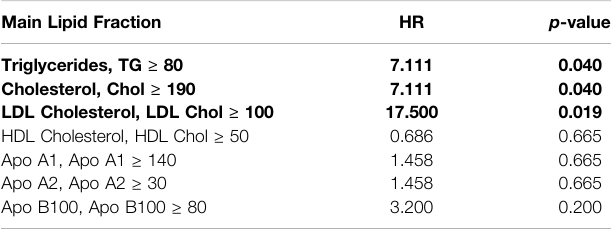
Abbreviations: HR, hazard ratio. Risk threshold for each lipid fractions were arbitrarily set at each median value. Associations with p values < 0.05 are reported in